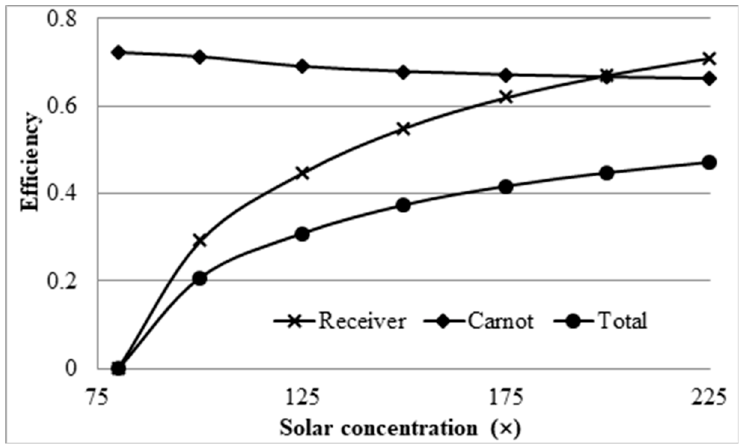
Figure 19. Effect of solar concentration on efficiency at a constant peak temperature. Figure 19. E ff ect of solar concentration on e ffi ciency at a constant peak temperature.